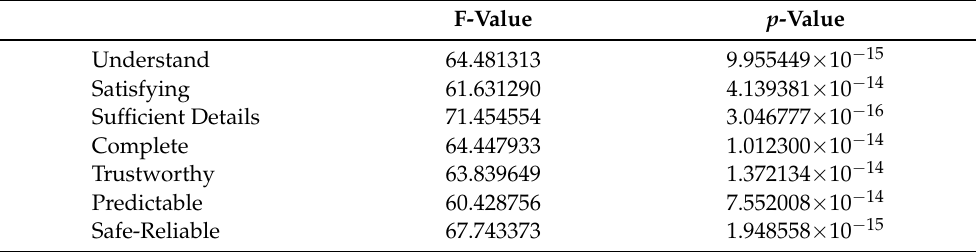
Figure 23. Box plot of the trust qualities of the explanations for the “Why not” question. Table 6. Table of the p -values obtained from Kruskal-Wallis’s test for the comparison of the counter- factual